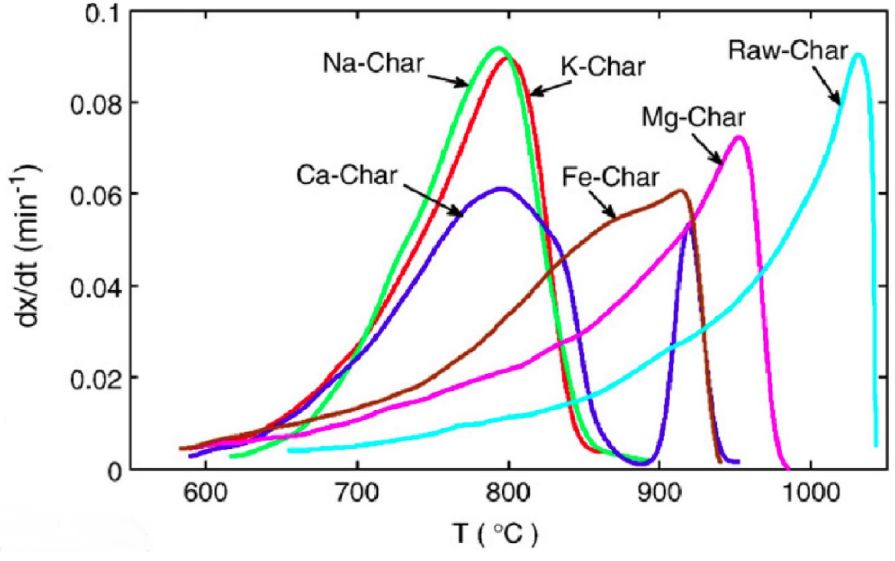
Figure 9. Gasification rates of different char samples with metal loading of 0.04 g/g [92].